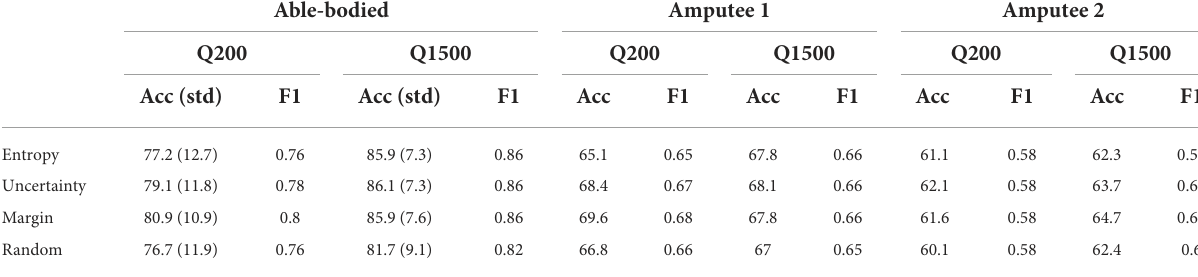
TABLE 2 Method comparison between query 200 and 1,500. All accuracy are reported in